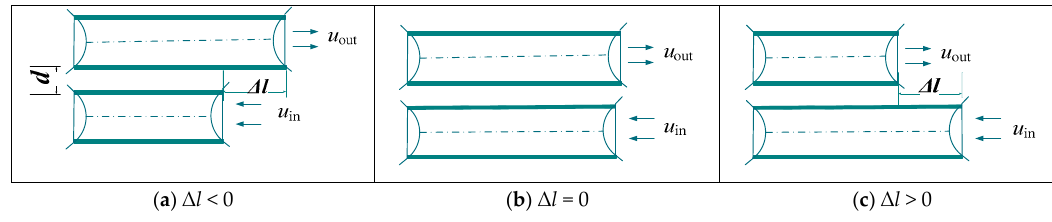
Figure 1. Sketch map of closely spaced twin tunnels with staggered inlet and outlet.